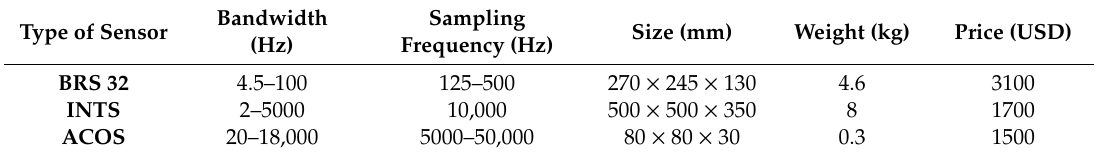
Table 2. Comparison of the basic parameters of the seismic station, the interferometric sensor and the acoustic